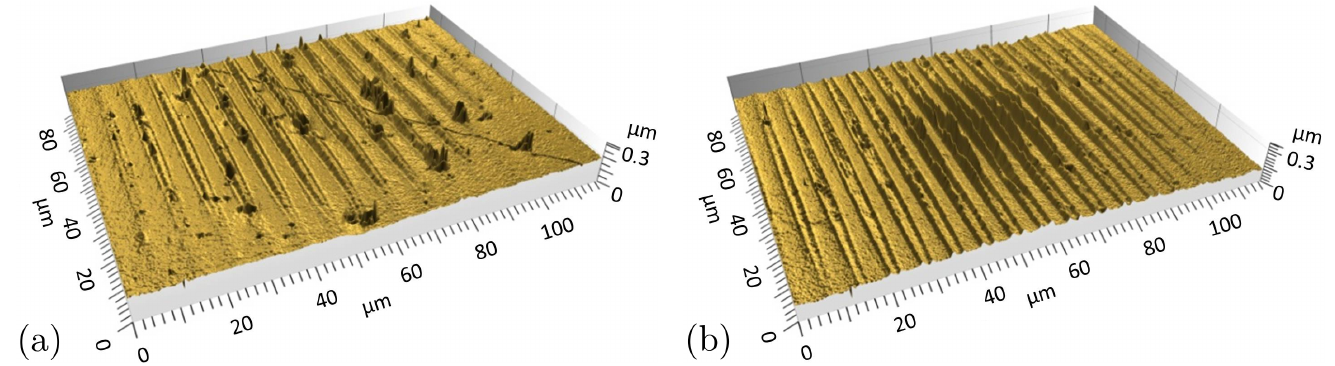
Figure 7. Three-dimensional confocal microscope images of DLIP laser spots on steel samples with different sulphur contents. ( a ) Single peak structures generated on steel with 30 ppm S content and Φ av,spot = 0.46 J/cm 2 , ( b ) split peak structures fabricated on steel with 300 ppm S content and Φ av,spot = 0.82 J/cm 2